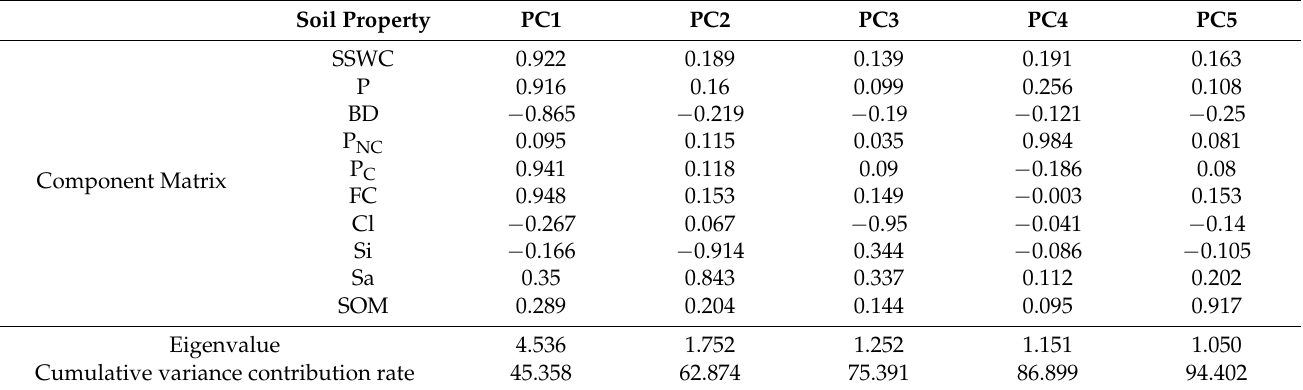
Table 2. Component Matrix after rotating by maximum variance. Soil